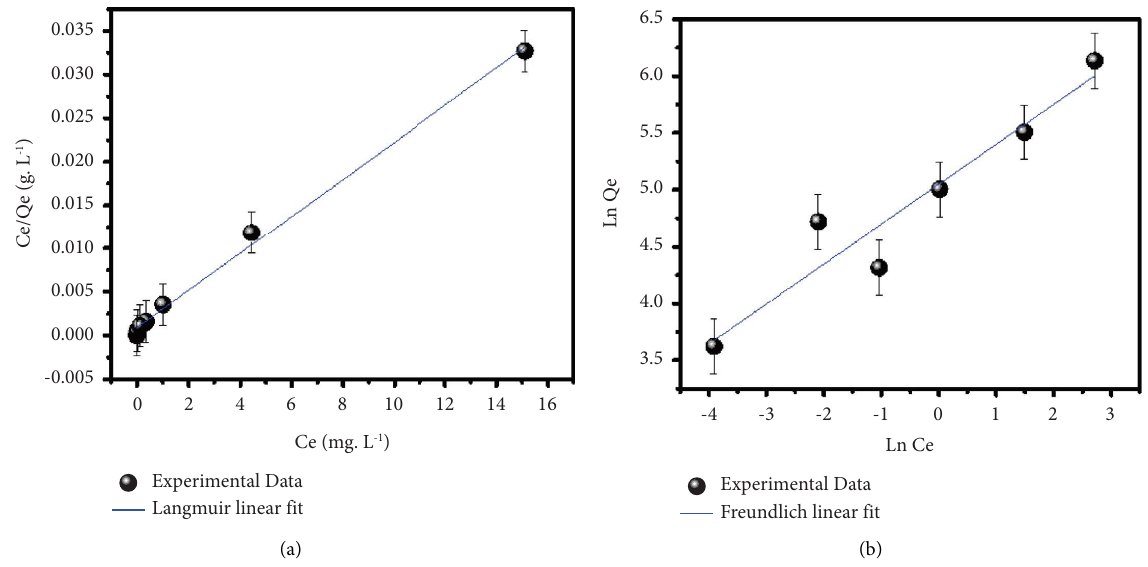
Figure 7: Experimental adsorption data ftted with the Langmuir (a) and Freundlich (b) models.